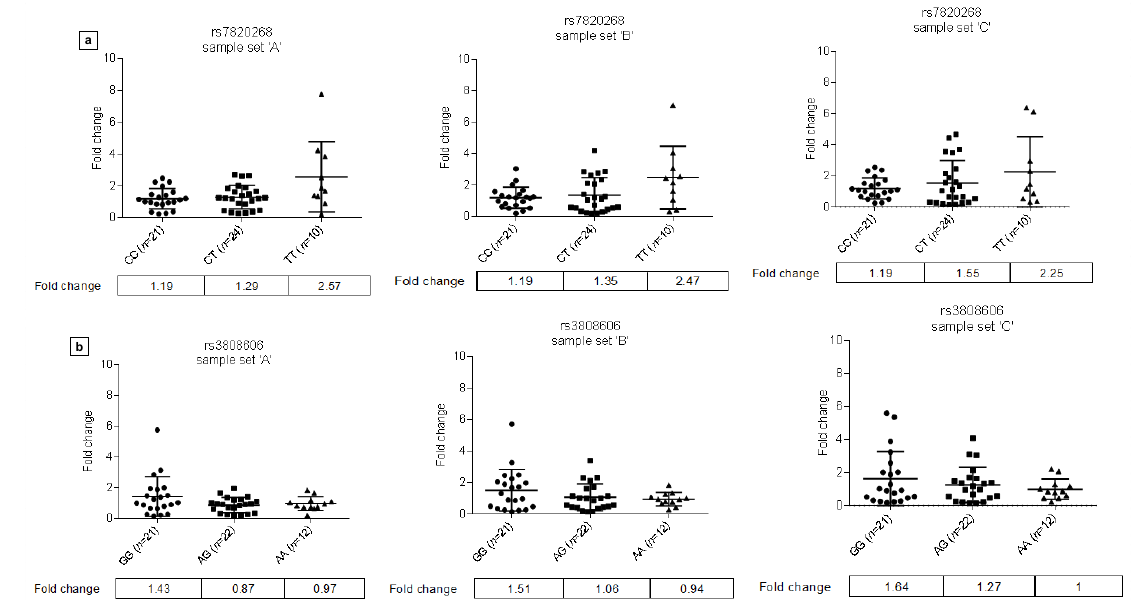
Figure 4. Effects of IDO1 variants on IDO1 mRNA level in peripheral blood samples of ischemic stroke patients. IDO1 rs7820268 (T) variant ( a ) and rs10089084 (C) variant (not shown) result in a trend towards elevated IDO1 mRNA level in peripheral blood samples of stroke patients, while IDO1 rs3808606 A variant ( b ) is associated with a tendency of reduced mRNA level. Blood samples were drawn before thrombolysis (sample set A) and 2–6 h, and 10–15 h after thrombolysis (sample sets B and C, respectively). The variants of IDO1 form a haplotype block, and rs7820268 and rs10089084 show strong linkage disequilibrium. Since the latter two variants result in similar changes in mRNA level, only data for rs7820268 SNP are presented.